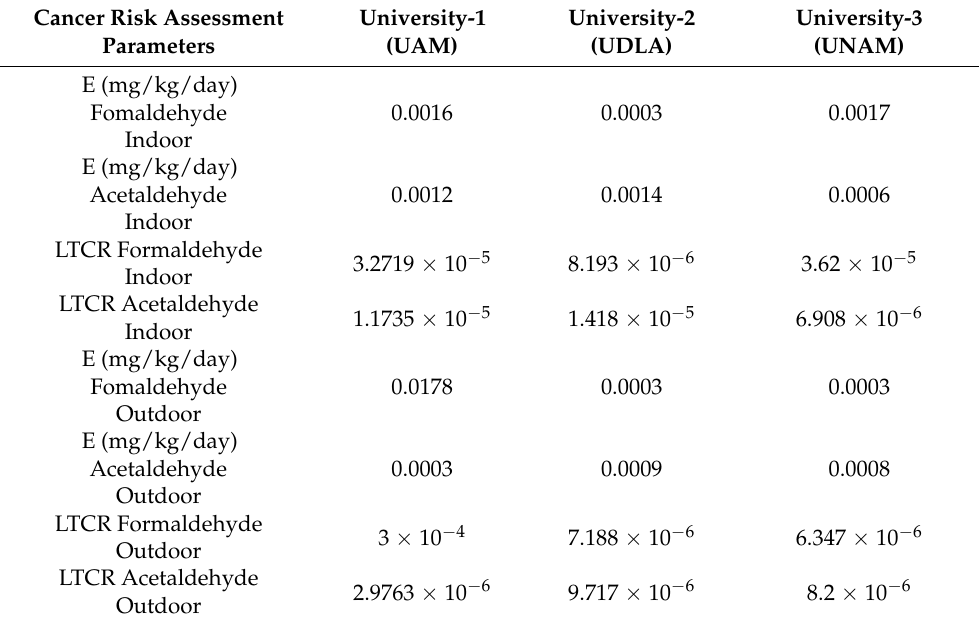
Table 9. Average values for cancer risk coefficients in lifetime (LTCR) and average daily exposure values for formaldehyde and acetaldehyde in the three sampling